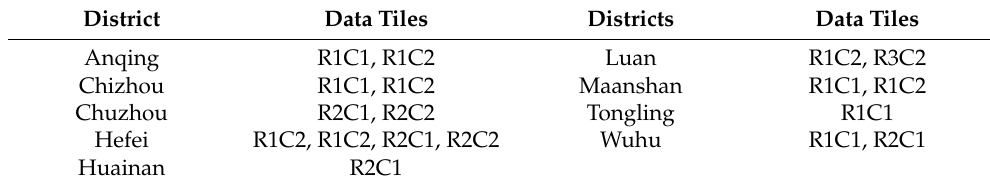
Table A1. Tiles of China’s impermeable surface product (2 m) were used in the study area. District Data Tiles